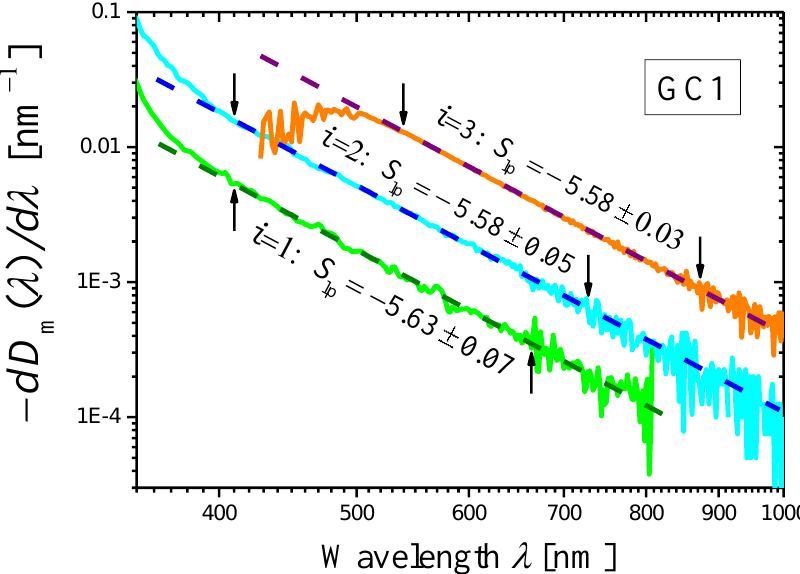
Figure 2. Log – log plots of the dependences of (−𝑑𝐷 𝑖 m (𝜆)/𝑑𝜆) on 𝜆 (curves) constructed for the measured optical densities 𝐷 𝑖 m (𝜆) (𝑖 = 1,2,3) of three samples of the glass-ceramic GC1. The thicknesses of samples are: ℎ 1 = 0.27 mm (green curve), ℎ 2 = 0.77 mm (cyan curve), and ℎ 3 = 3.02 mm (orange curve). The portion of each curve limited by arrows is approximated by a dashed straight line using the least squares method, and the slope 𝑆 lp of the straight line is indicated in the figure.